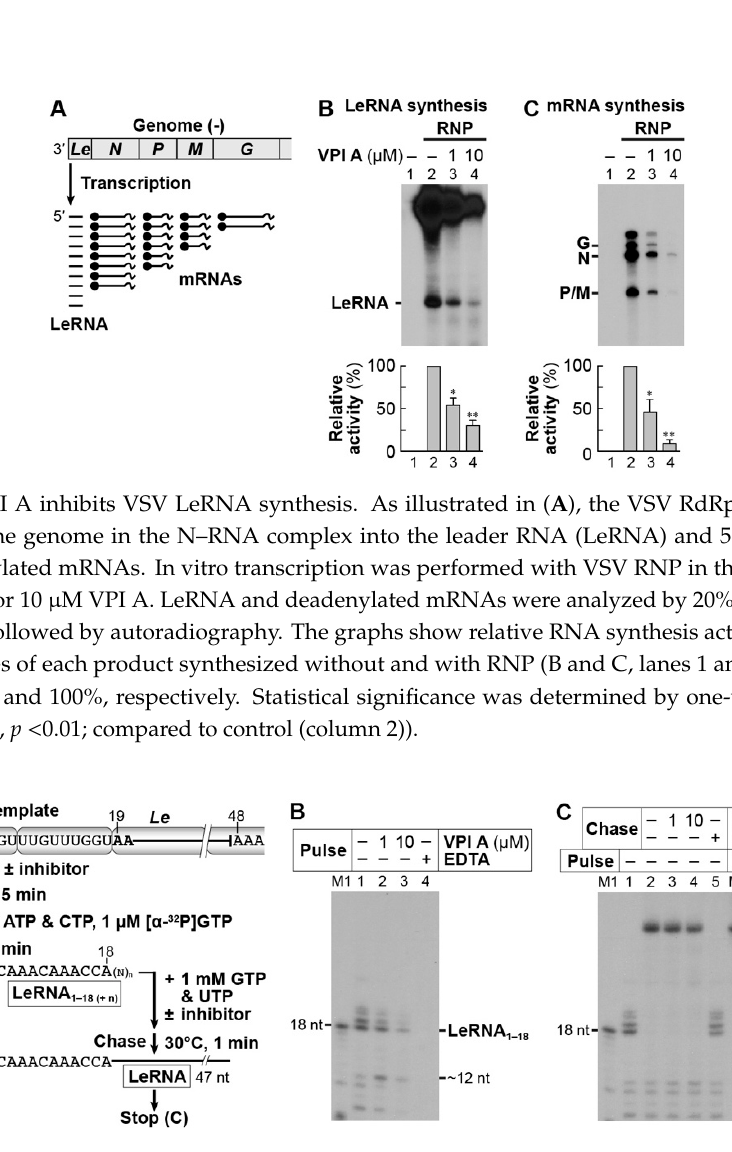
Figure 8. VPI A inhibits an early step of VSV LeRNA synthesis. The experimental design for pulse-chase transcription is schematically represented in ( A ). Partial RNA sequences of the 3 ′ -terminal VSV genome and 5 ′ -terminal LeRNA are shown. The recombinant VSV L and P proteins was premixed with the N–RNA template in the presence or absence of VPI A (1 or 10 µM) or EDTA (25 mM). After adding ATP, CTP, and [ α - 32 P]GTP to the reactions, 32 P-labeled LeRNA with residues 1–18 (LeRNA 1–18 ) was synthesized for 3 min ( pulse ). The reactions were stopped ( B ) or proceeded to further RNA chain elongation with excess concentrations of GTP and UTP in the presence or absence of VPI A (1 or 10 µM) or EDTA (25 mM) ( C , chase ). Transcripts were analyzed by 20% urea-PAGE followed by autoradiography. M1 and M2 lanes indicate 32 P-labeled LeRNA 1–18 and LeRNA synthesized by T7 RNA polymerase and VSV RNP, respectively.